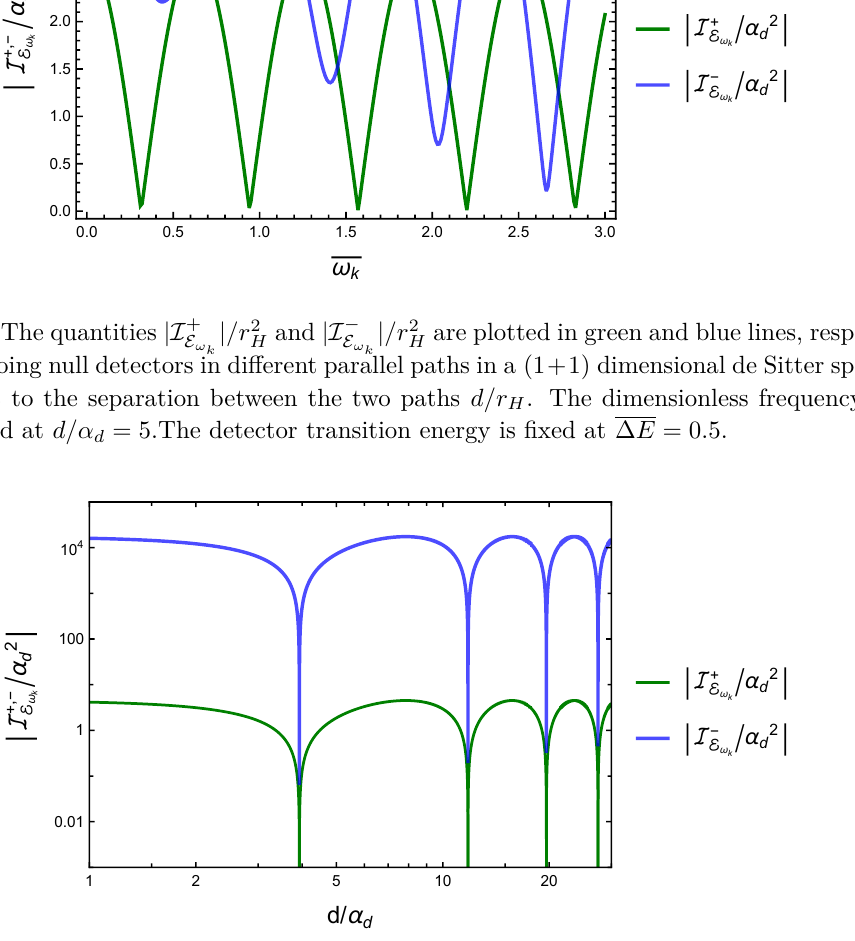
and |I − are plotted in green and blue lines, respectively Figure 30 . The quantities |I + | /r 2 | /r 2 H H E ωk E ωk for two outgoing null detectors in different parallel paths in a (1+3) dimensional de Sitter spacetime with respect to the separation between the two paths d/r . The dimensionless frequency of the H field are fixed at ω = 0 . 8 . The detector transition energy is fixed at ∆ E = 0 . 5 k